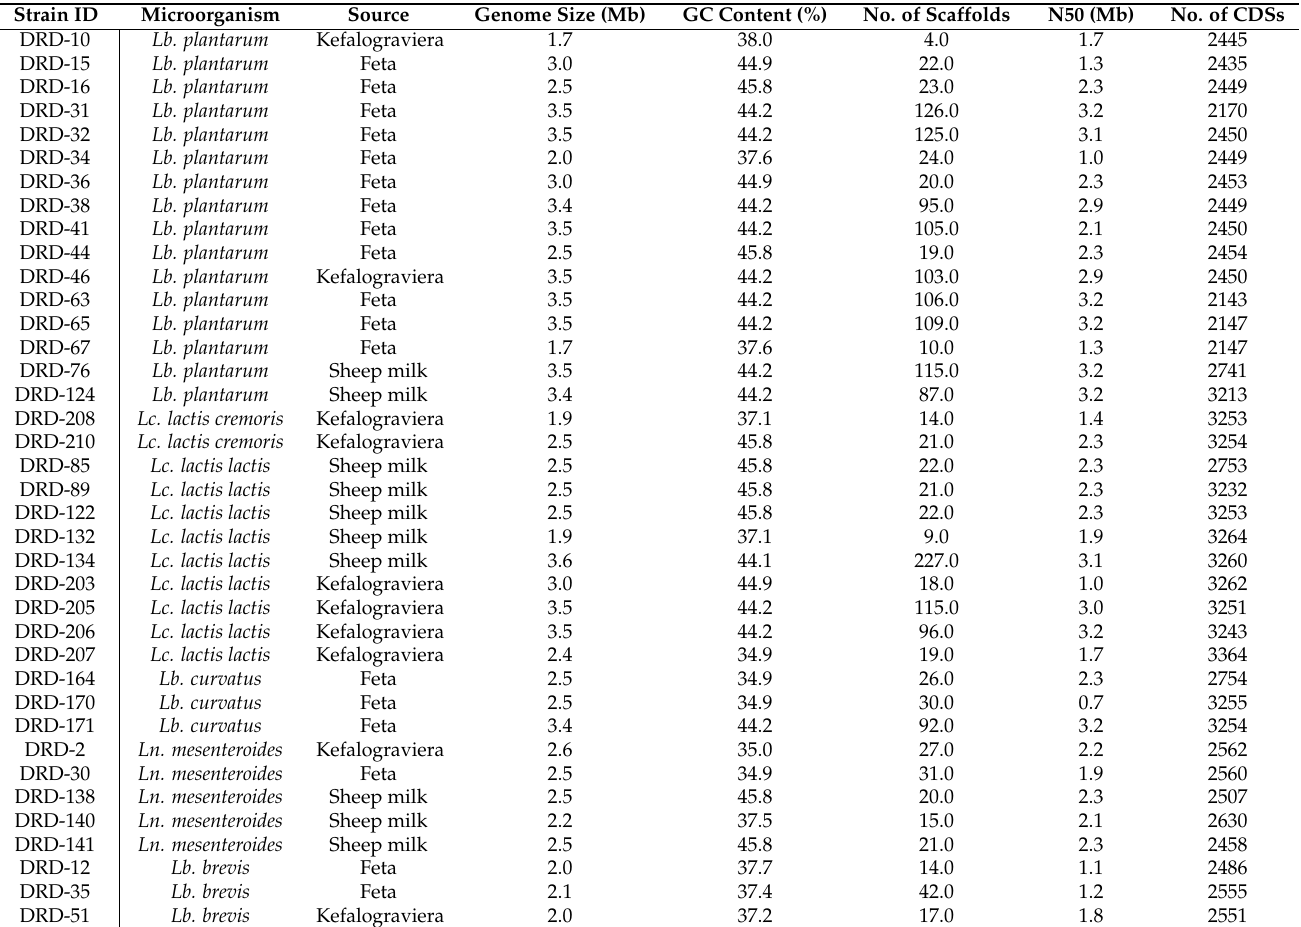
Table 1. Species identification and assembly statistics for all LAB